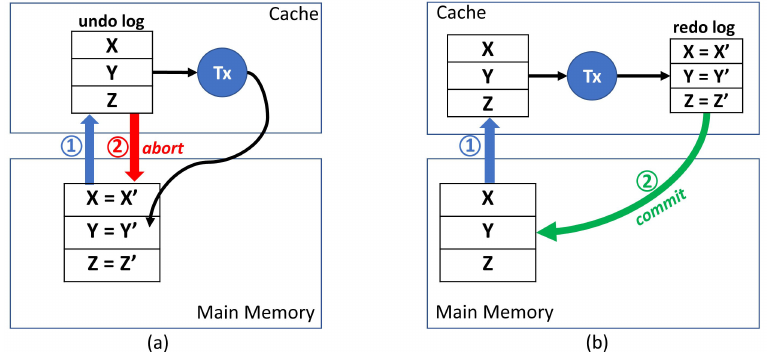
Figure 2. An illustration of how a transaction T x is executed in non-persistent memory using ( a ) eager versioning and ( b ) lazy versioning. Figure ( a ) depicts two kinds of operations in eager versioning. The first operation is to copy the data from original memory locations to a log area (called undo log) in cache. Transaction T x then performs in-place updates to the original memory locations. Now, the second operation is to copy the data back from the log area to the original memory locations, in case T x aborts. If T x commits, the data in the log area is simply discarded. Figure ( b ) depicts two kinds of operations in lazy versioning. The first operation is to copy the data from original memory locations to a log area (called redo log) in cache. Transaction T x updates on this redo log. Then, the second operation is to copy updated data from the log area to the original memory locations, in case T x commits. If T x aborts, the data in the log area is simply discarded.